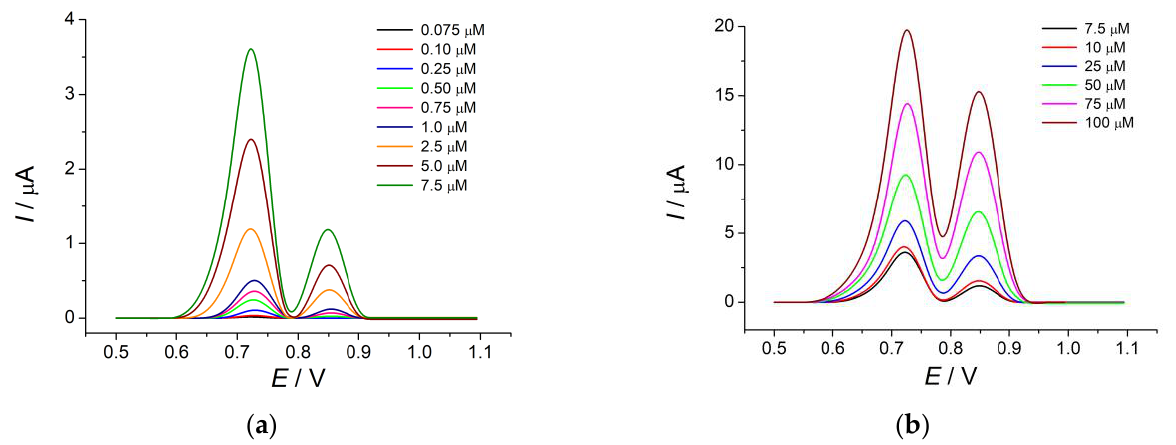
Figure 9. Baseline-corrected differential pulse voltammograms of the aromatic aldehydes equimolar mixtures of various concentrations at the poly( p -ABA)-modified electrode in the Britton–Robinson buffer pH 2.0: ( a ) concentration range of 0.075–7.5 µ M; ( b ) concentration range of 7.5–100 µ M. Pulse amplitude is 50 mV, pulse time is 25 ms, potential scan rate is 10 mV · s − 1 . Table 4. Analytical characteristics and parameters of calibration graphs for aromatic aldehydes. Detection Analyte